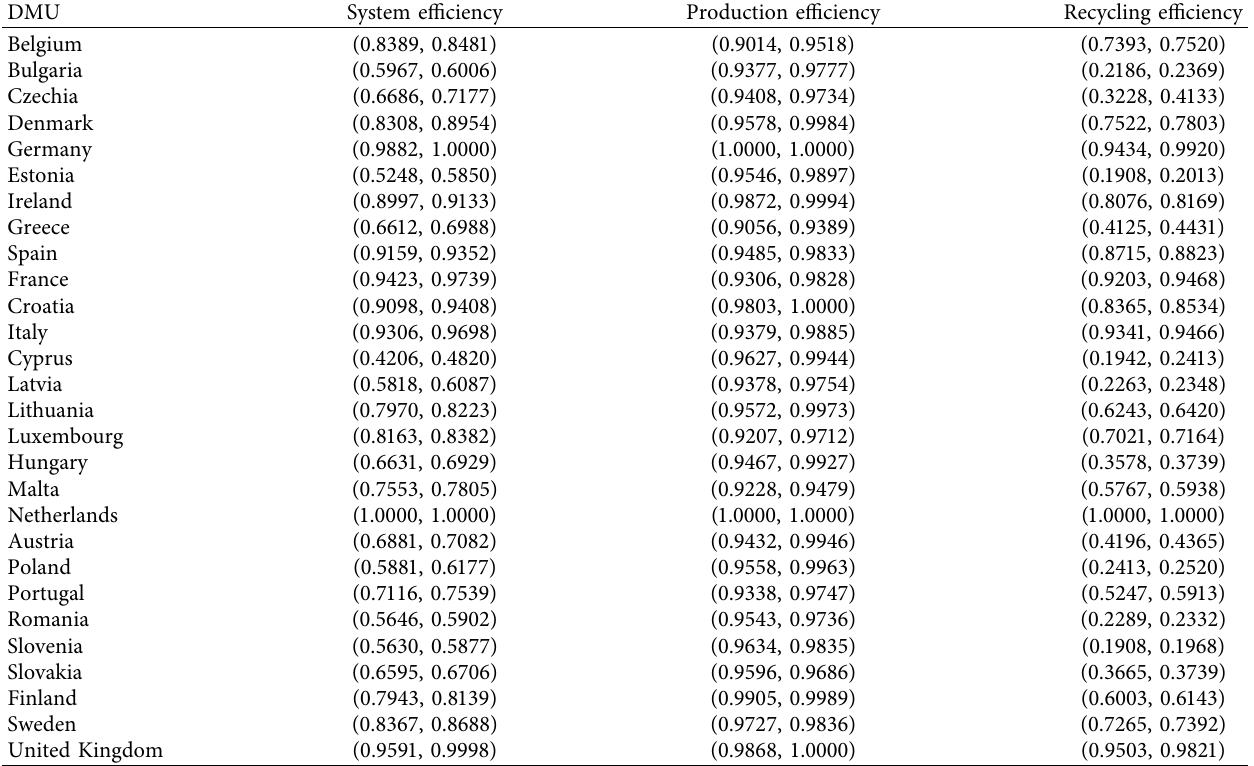
Table 2: The α -cuts of fuzzy